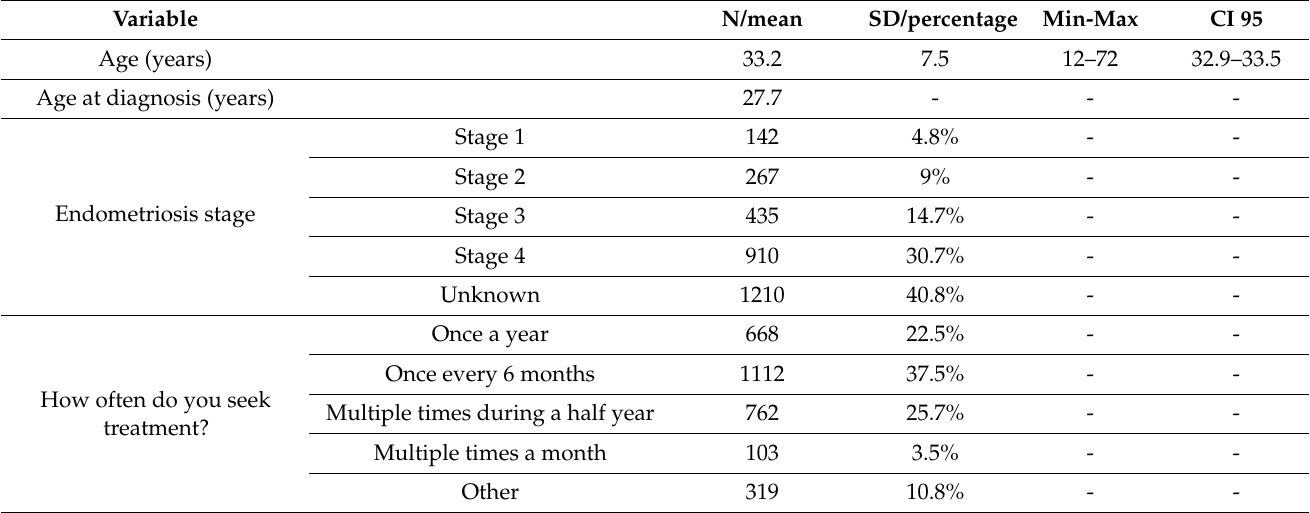
Table 1. Demographic and clinical characteristics of women with endometriosis who completed the